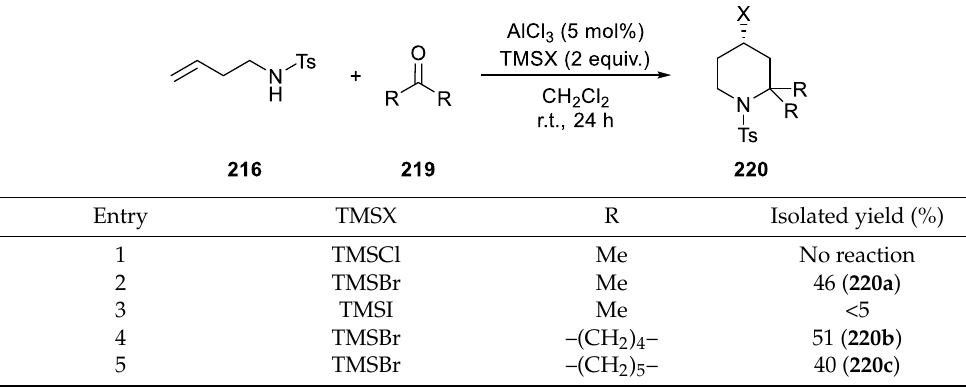
Table 9. AlCl 3 - catalyzed Prins reactions of different ketones with N - tosyl homoallylamine.